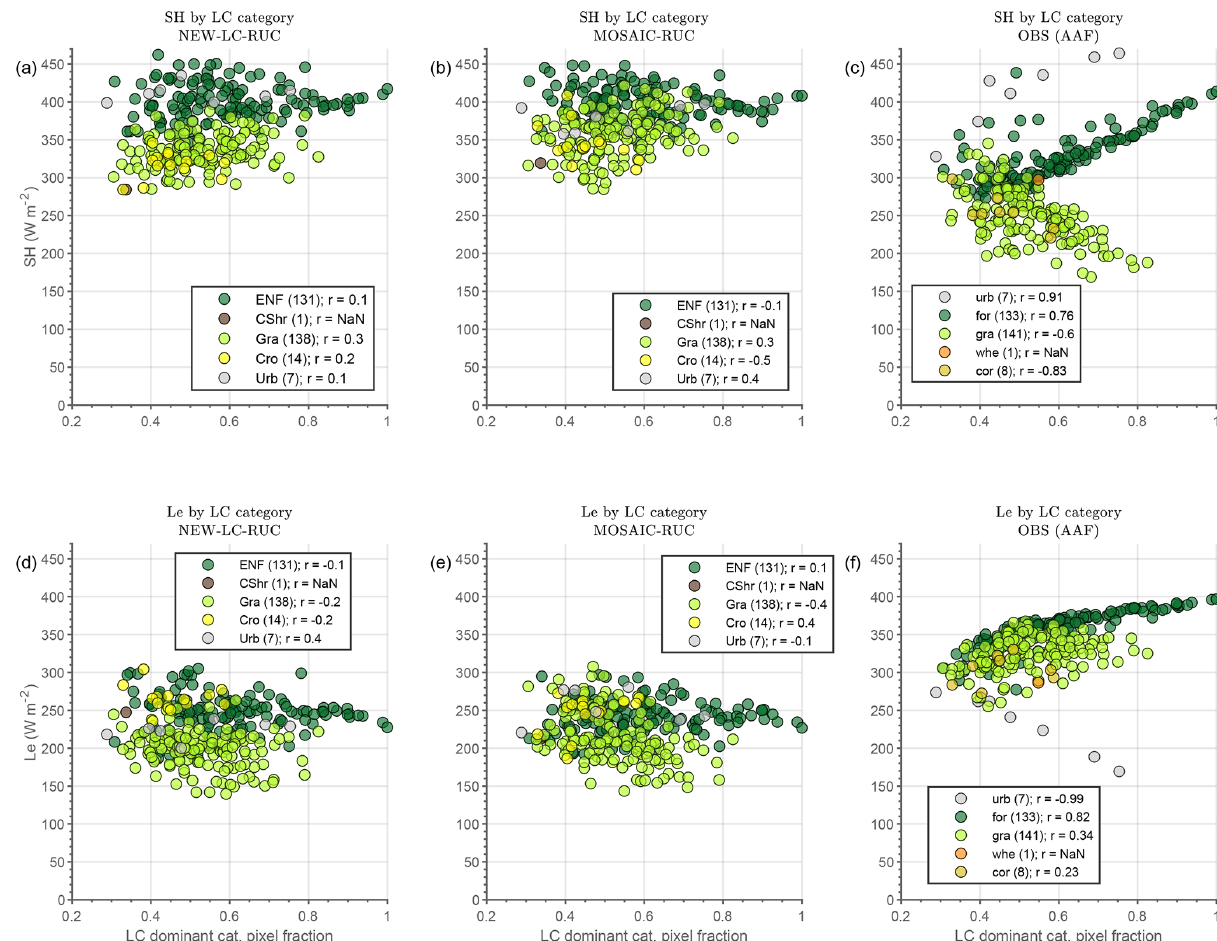
Figure 8. Same as in Fig. 7 but for NEW-LC-RUC (dominant) and MOSAIC-RUC (mosaic).